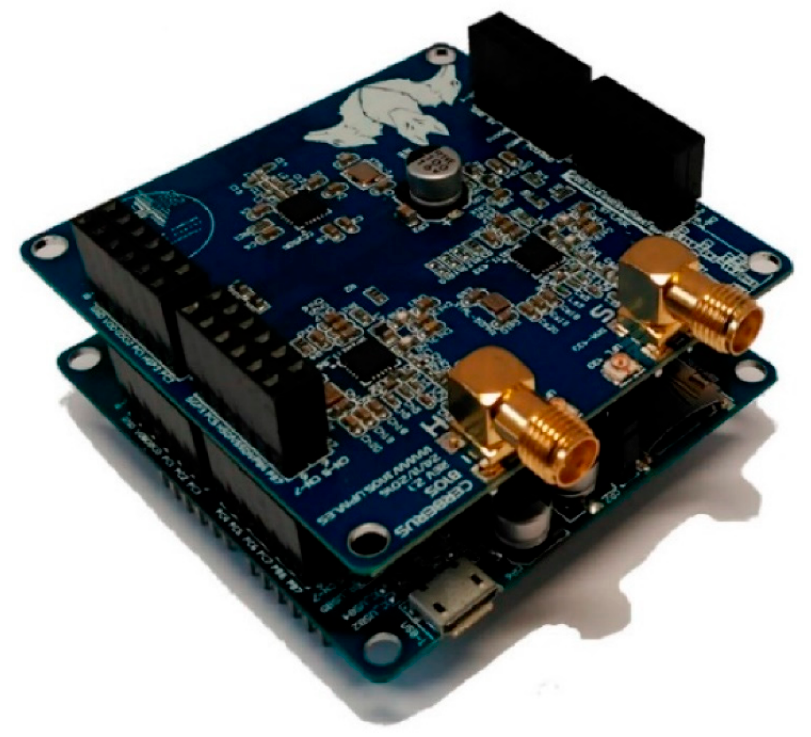
Figure 1. YetiMote